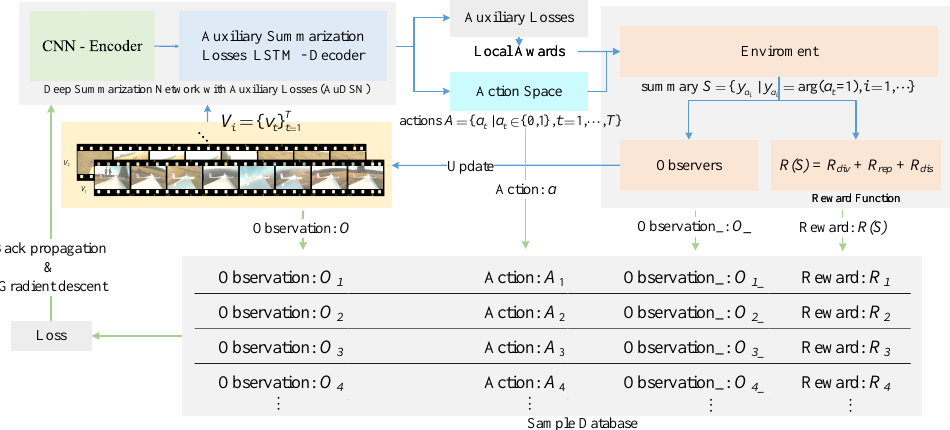
Figure 2. Pipeline of the proposed AuDSN. The blue arrow represents the process of generating a summary and the green arrow represents the process of model